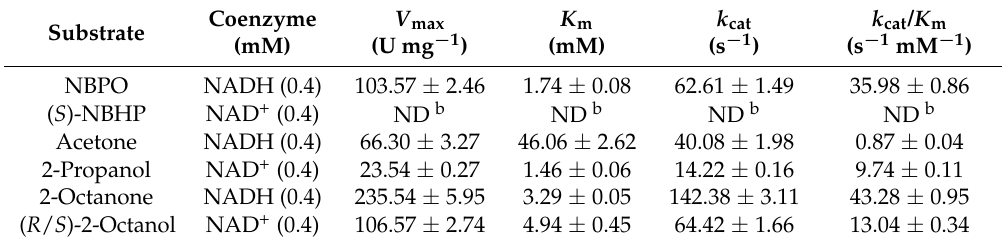
Table 2. Kinetic parameters of recombinant ReCR a